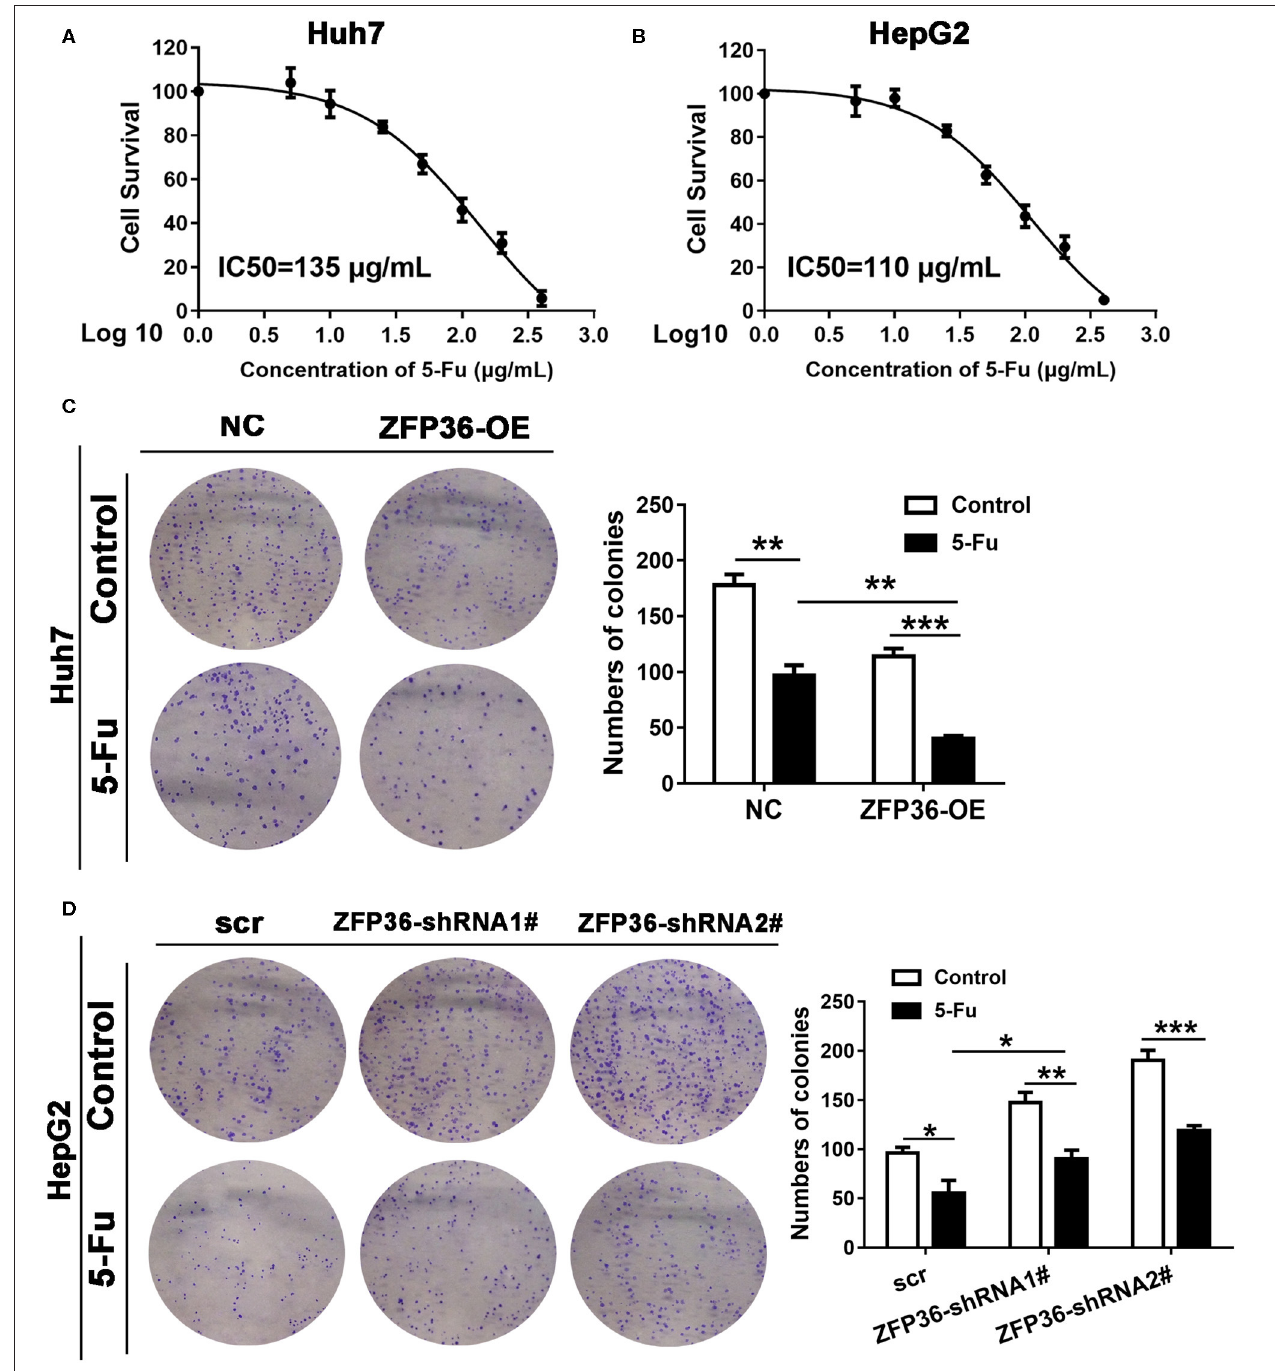
FIGURE 4 | Overexpression of ZFP36 increases sensitivity to 5-Fu treatment in vitro . (A,B) Huh7 and HepG2 cells were treated with 0, 5, 10, 25, 50, 100, 200, and 400 µ g/ml 5-Fu for 7 days, to determine the half maximal inhibitory concentration (IC50). The IC50 of Huh7 cells is 135 µ g/ml and the IC50 of HepG2 cells is 110 µ g/ml. (C,D) A colony formation assay of Huh7 cells transfected with ZFP36 and HepG2 cells transduced with ZFP36 shRNA1# or 2#. Cells were grown for 14 days with or without 135 µ g/ml 5-Fu for Huh7 cells or 110 µ g/ml 5-Fu for HepG2 cells and stained with crystal violet. The colonies were counted and captured. * p < 0.05, ** p < 0.01, *** p < 0.001. PRC1 was significantly higher in Huh7 than in HepG2. Silencing expression in the HCC cell lines HepG2, SNU475, Hep3B, and PRC1 led to the significantly reduced growth of Huh7 cells Huh7 and the normal liver cell line LO2 ( Figure 6A ). In contrast ( Figures 6B–D ) whereas overexpressing PRC1 in HepG2 with the results obtained for ZFP36 ( Figure 2A ), expression of